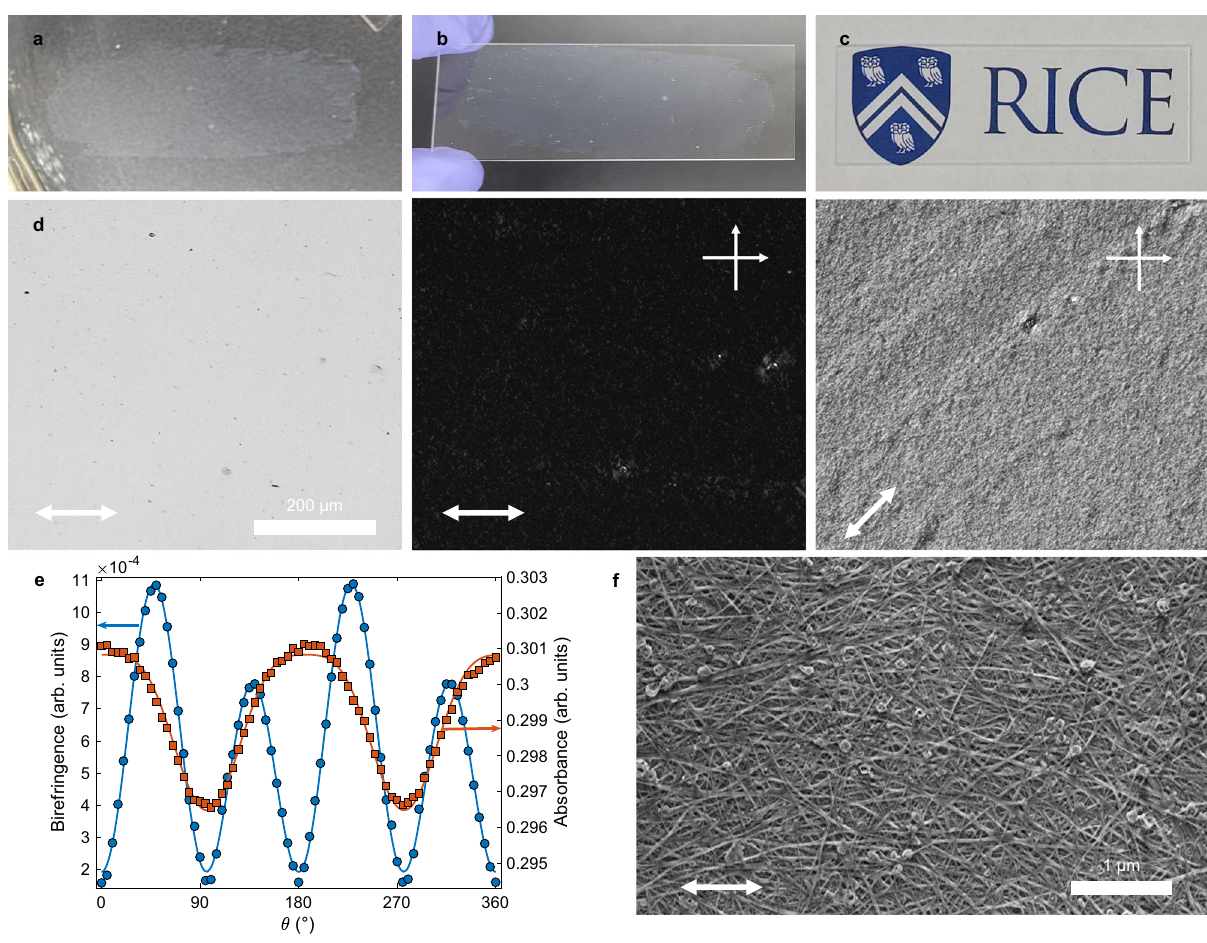
Fig. 3 Aligned fi lms of BNNTs. a Photograph of a BNNT fi lm made from a ~1 wt% solution of highly puri fi ed BNNTs (HP-BNNTs) fl oating on water with its original structure intact. b Photograph of the same fi lm as in a redeposited onto a new glass slide and held at an angle to observe the fi lm more easily. c Photograph of the BNNT fi lm from b on the glass slide laid over the Rice shield, demonstrating high transparency. d Polarized light microscopy (PLM) images of the BNNT fi lm on a glass slide: unpolarized transmitted light image and polarized light images with polarizer/analyzer at fi xed at 0°/90°. The fi lm was rotated to 45° for the last polarized light image and the double-sided white arrows in the lower left corners of the PLM images indicate the orientation of the shear axis for the fi lm. e Plot of HP-BNNT fi lm birefringence intensity normalized by incident light intensity (circles) and fi lm absorbance (squares) against stage rotation angle. Birefringence intensity and absorbance are both plotted with model fi ts with coef fi cients of determination ( r 2 ) of 0.996 and 0.991, respectively. f Scanning electron micrograph of the BNNT fi lm on glass. The double-sided white arrow indicates the shear axis for the fi lm on SEM